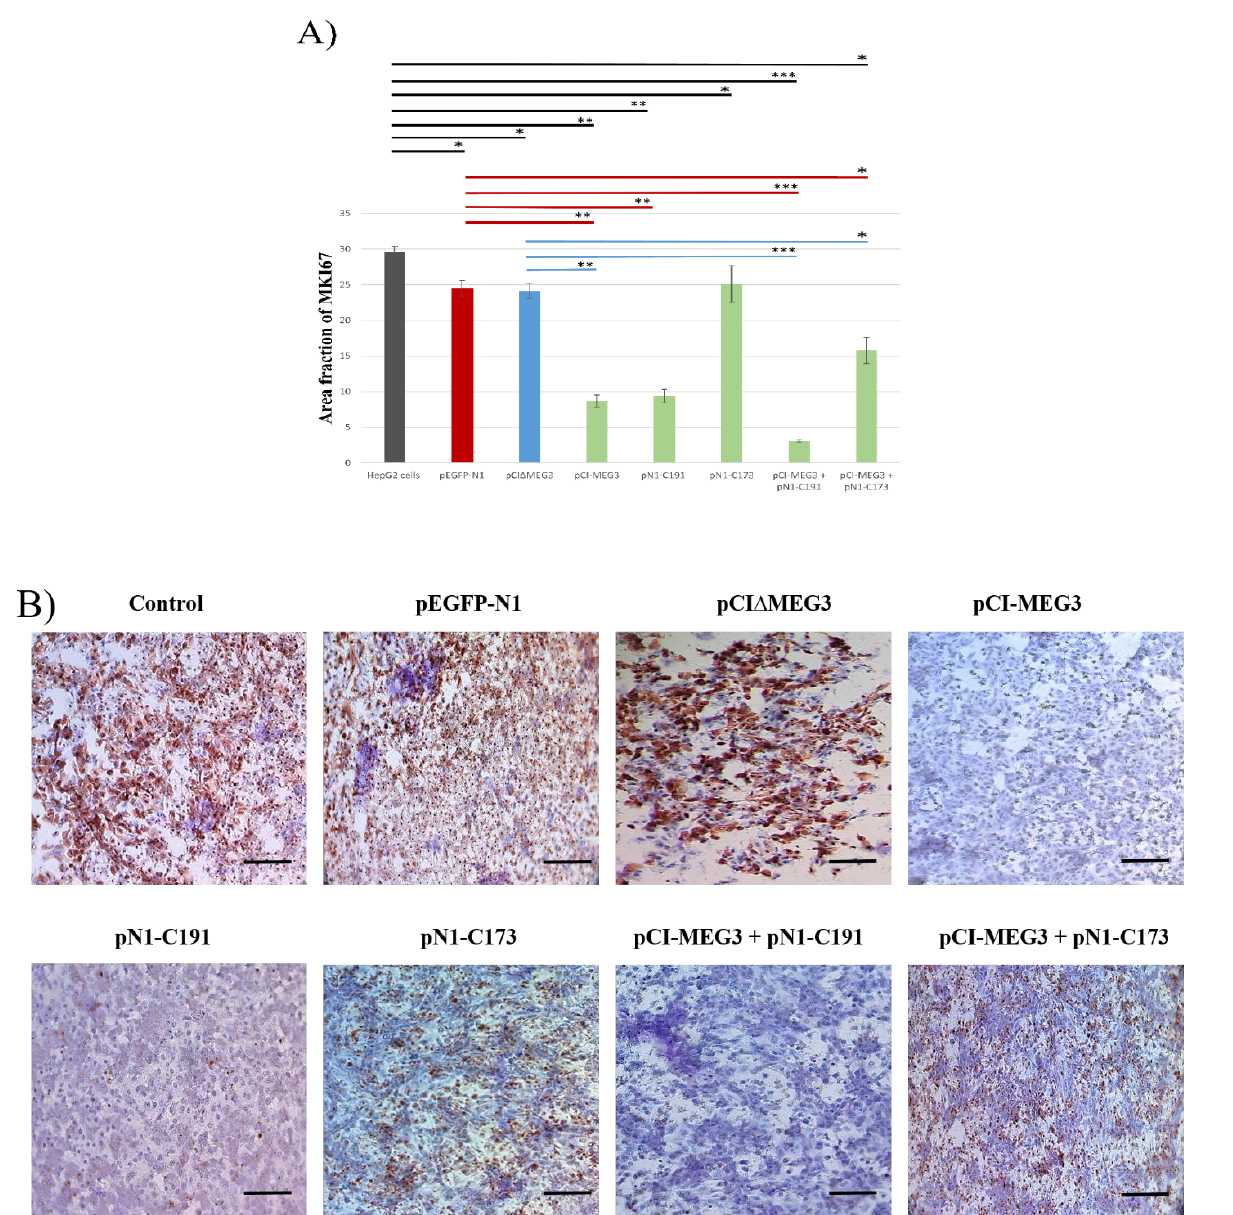
Figure 4. ( A ). Area fraction of MKI67 expression level in HepG2 cells transfected with different plasmids. Data presented as mean ± SD. (*) shows the p -value < 0.05, (**) shows the p -value < 0.01 and (***) shows p -value < 0.001 compared to control untransfected HepG2 cells, pEGFP-N1 and pCI∆MEG3. Colored lines represent the significance of MKI67 expression in HepG2 cells between each sample and its control. Controls are divided into (a) HepG2 cells (Black), (b) HepG2 cells transfected with pEGFP-N1 (Red), and (c) HepG2 cells transfected with pCI ∆ MEG3 (Blue). ( B ) Representative Photomicrographs of MKI67 expression by ICC assay in transfected and co-transfected HepG2 cells with different plasmids. Scale bar 100 µ